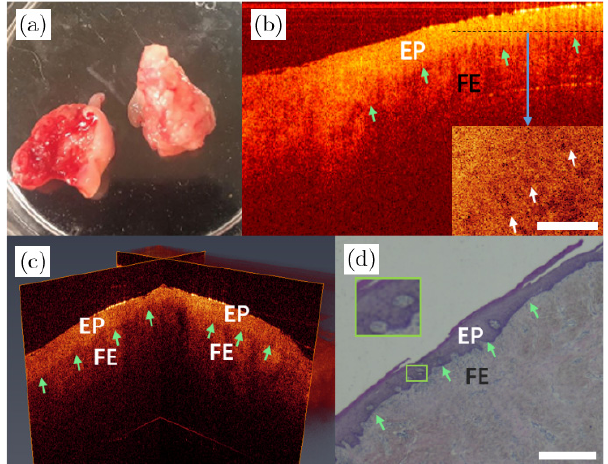
Fig. 6. Images of ¯brous epulis. (a) Photo of the excised tissue specimen. (b) The 2D OCT image and en - face OCT image from the dashed line of ¯brous epulis. (c) The 3D OCT image and (d) its histopathological image. EP: epithelial tissue and FE: ¯brous